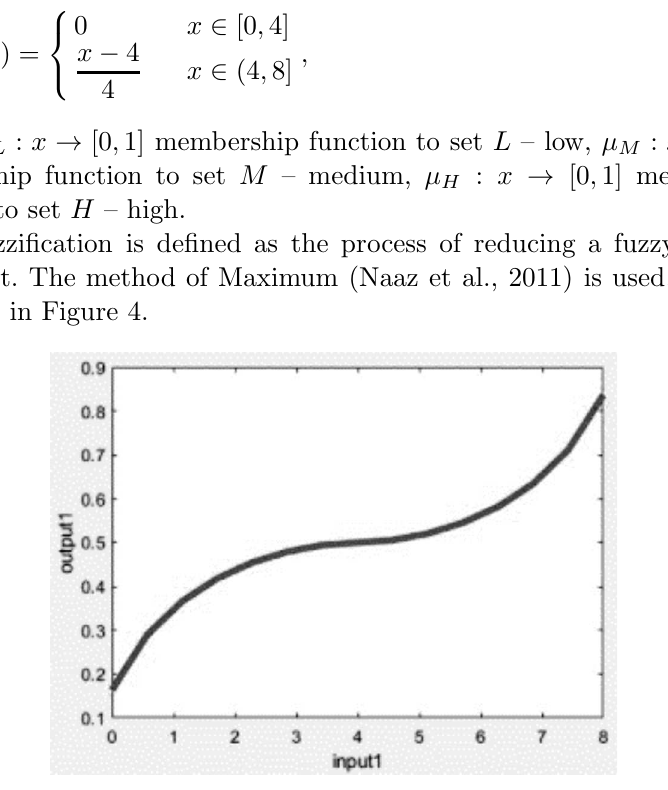
Figure 4. Defuzzification